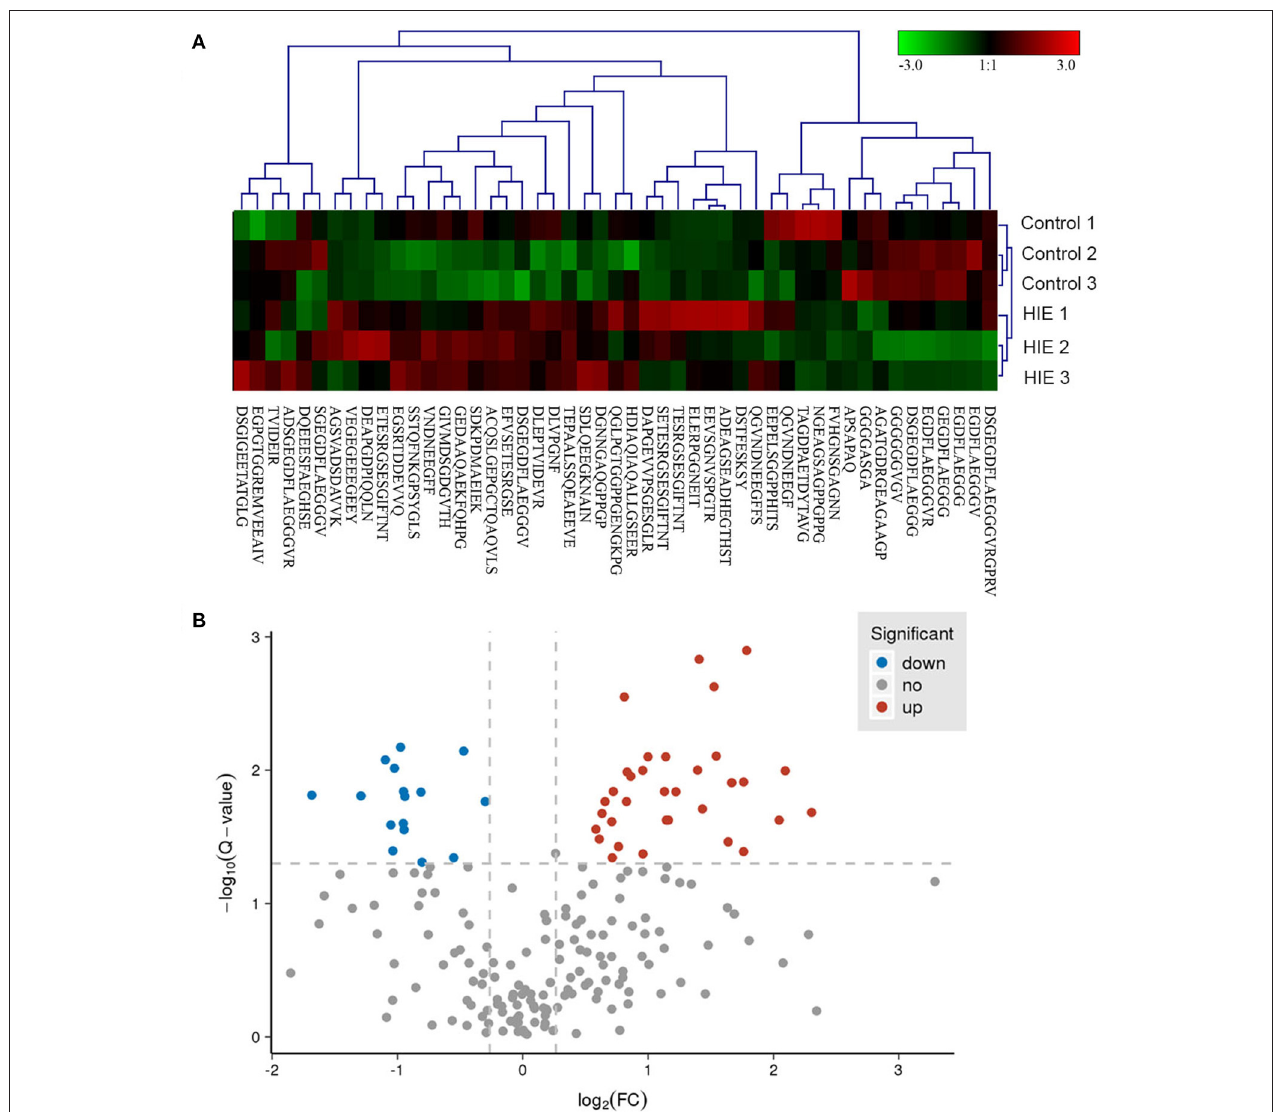
FIGURE 2 | Hierarchical clustering and volcano map of differentially expressed peptides. Hierarchical clustering of differentially expressed peptides (A) . Volcano map of differentially expressed peptides (B) .